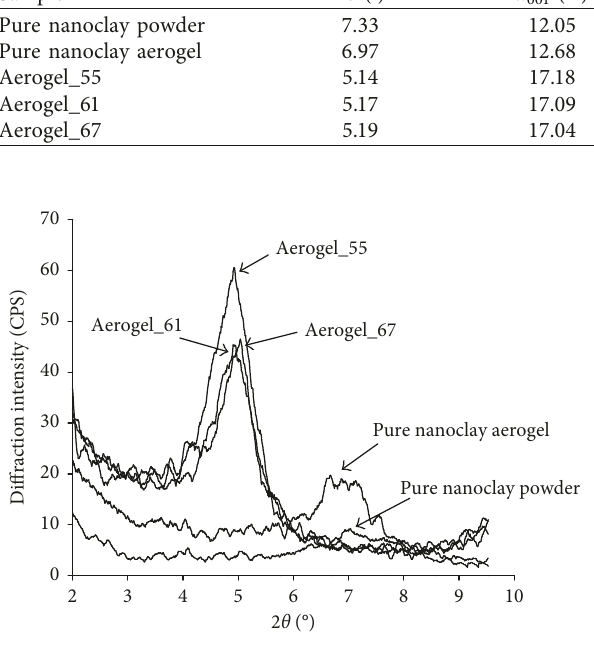
Figure 2: XRD patterns of nanoclay aerogel